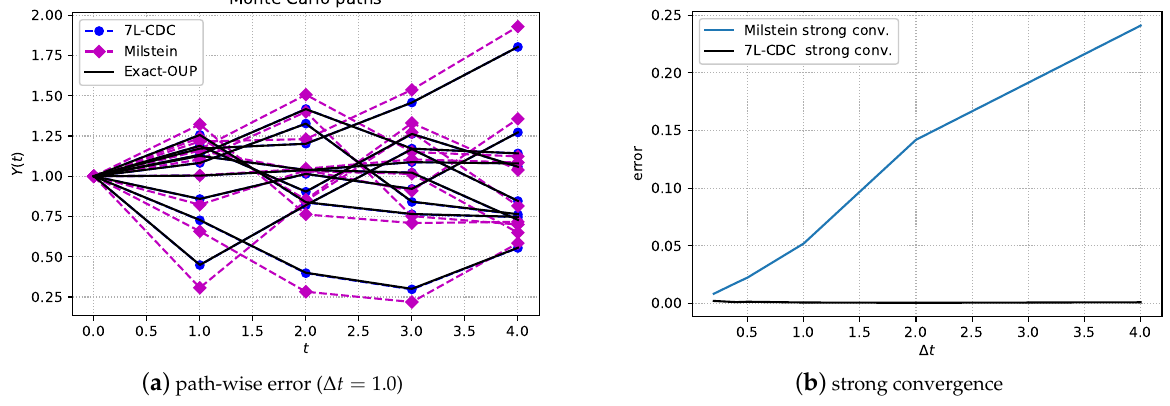
Figure 8. Paths and strong convergence for the OU process, using λ = 0.5, Y = 1.0, σ = 0.3, Y 0 = 1.0. The sample paths with barycentric, Chebyshev and PCHIP interpolation overlap for the 7L-CDC scheme. There are five marginal and five conditional SC points at each time